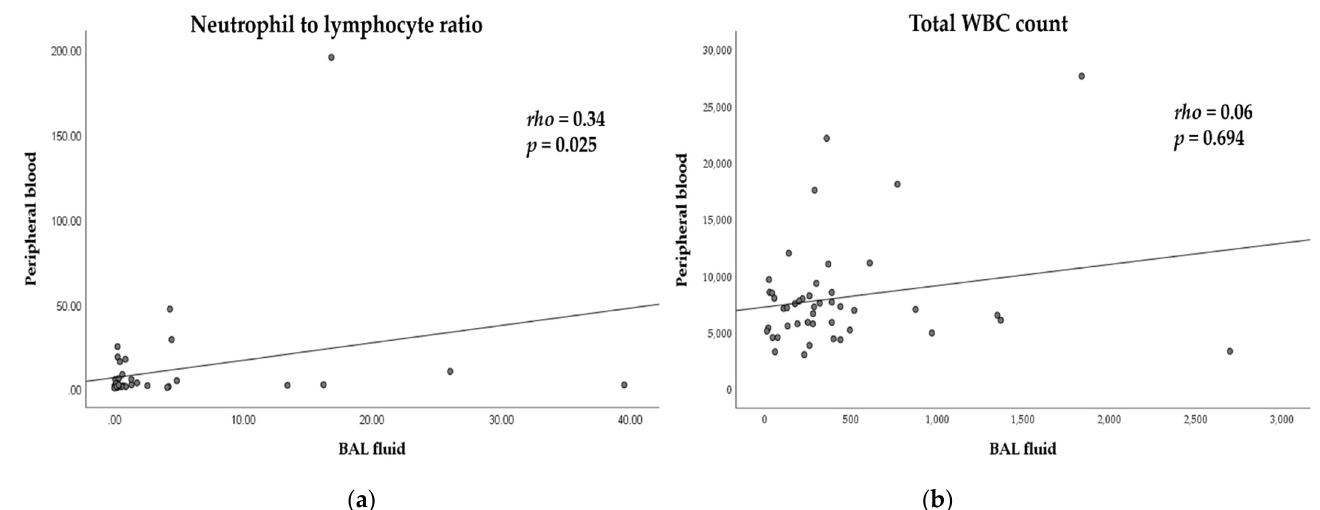
Figure 1. Correlation between bronchoalveolar lavage (BAL) fluid and peripheral blood. Scatter plots illustrating the correlation ( a ) between the neutrophil-to-lymphocyte ratio in BAL fluid (bNLR) and peripheral blood (pbNLR), and ( b ) between the total WBC count in BAL fluid and peripheral blood.